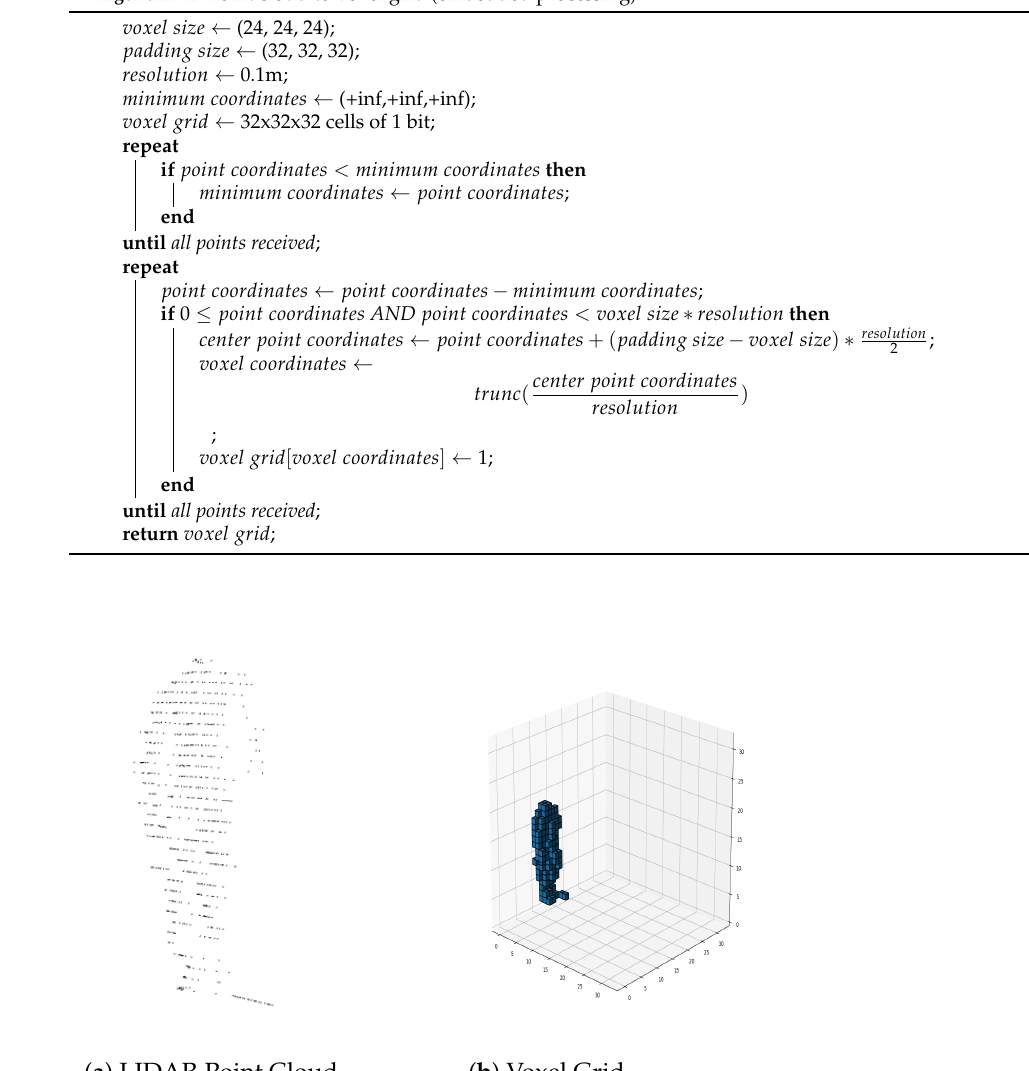
Algorithm 4: Point cloud to voxel grid (embedded processing).